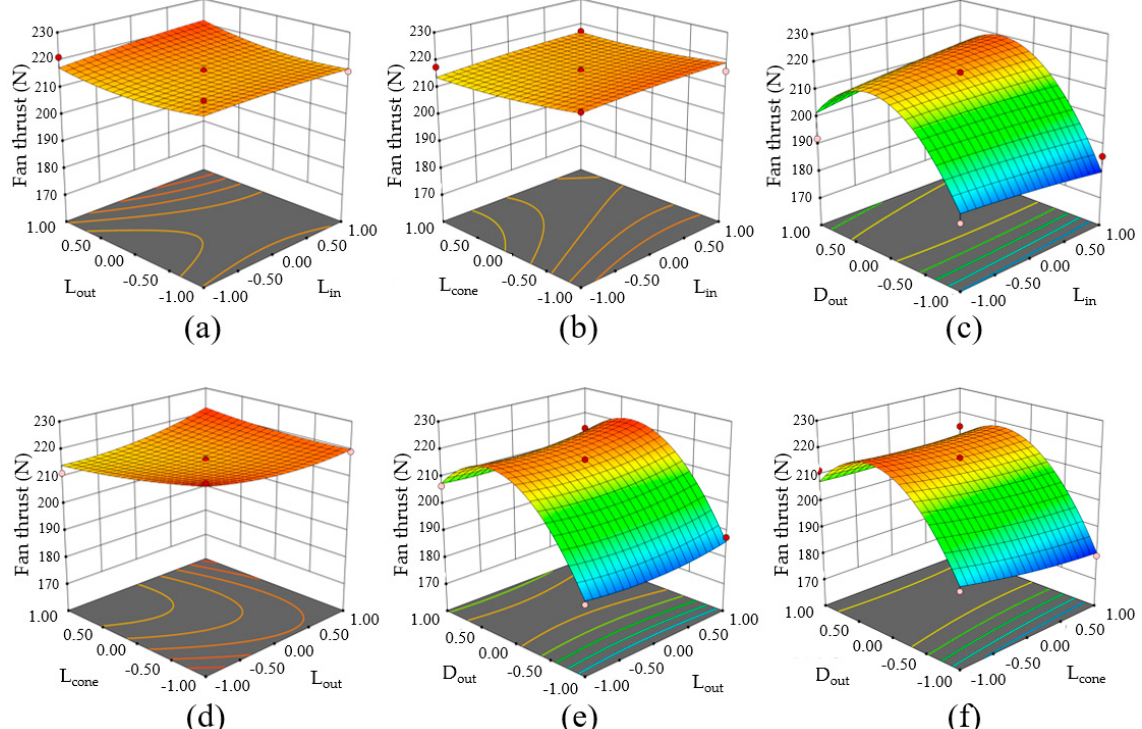
Figure 12. Two-factor interaction analysis. ( a )—Interaction between L in and L out ; ( b )—Interaction between L cone and L in ; ( c )—Interaction between L in and D out ; ( d )—Interaction between L cone and L out ; ( e )—Interaction between L out and D out ; ( f )—Interaction between L cone and D out